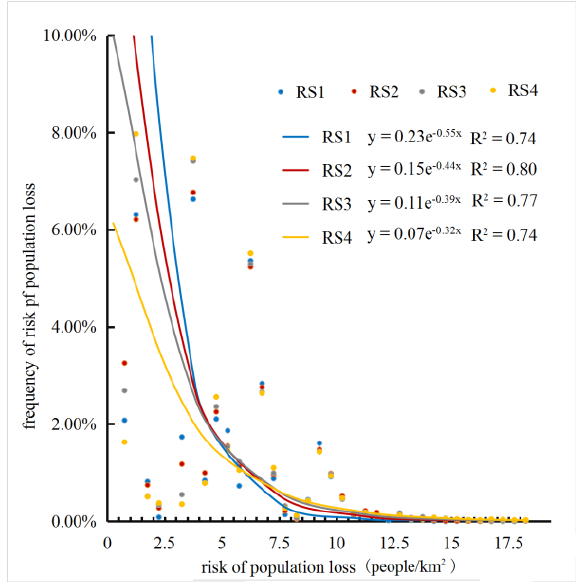
Figure 8. The probability distribution and curve fitting of the population loss risk posed by the disaster chain.